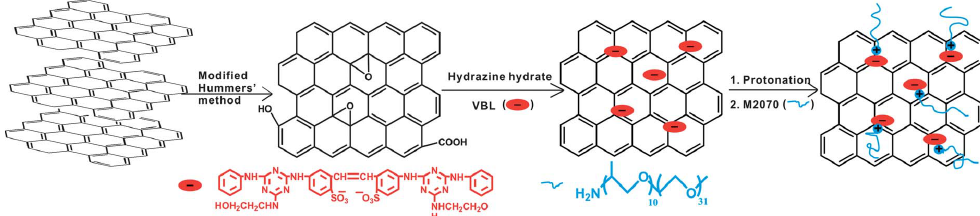
Figure 9. Schematic of the graphene NIM using a fluorescent whitening agent, VBL, as a non-covalent modifier and Jeffamine M-2070 as canopy. Reprinted with permission from Tang et al.